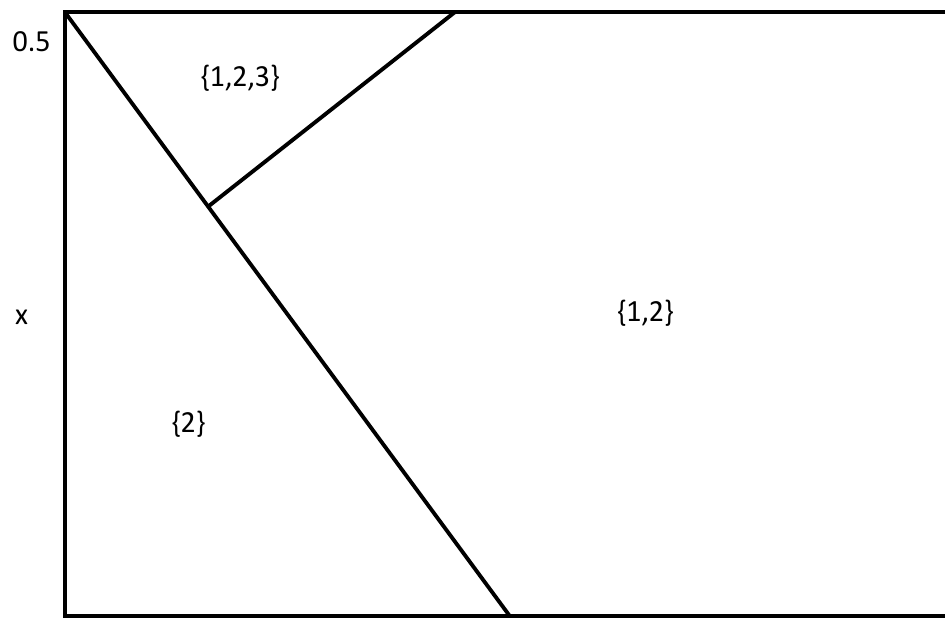
Figure 1. Coalitions with 2 as